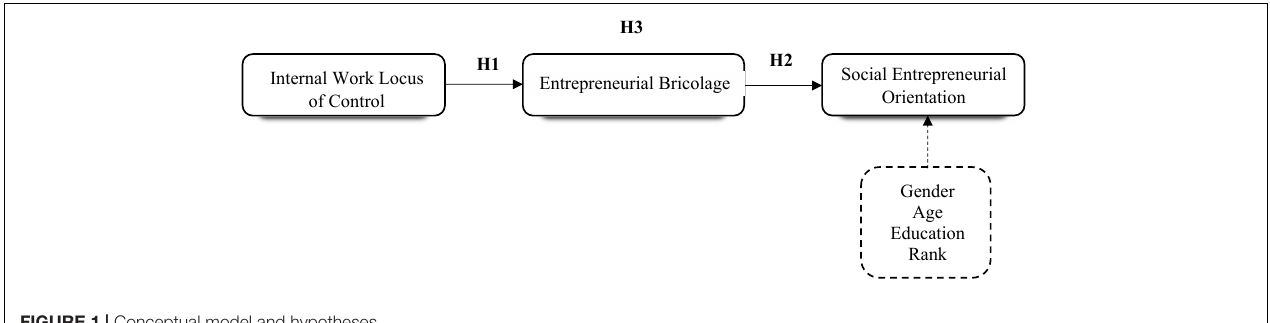
FIGURE 1 | Conceptual model and